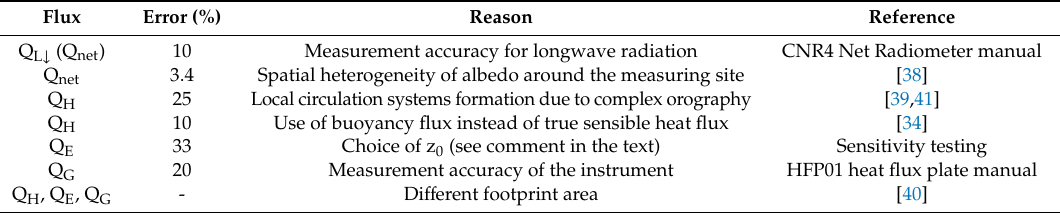
Table 2. Probable error of measurement for di ff erent fluxes in this